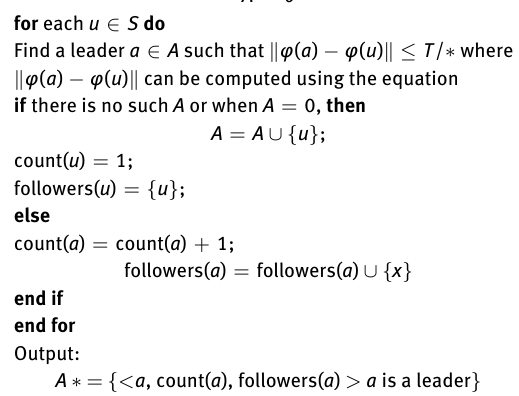
Table 1: Algorithm for Kernel-Based Leaders Clustering Method. Algorithm 1: Kernel-based leaders clustering method ( S , T ) A =